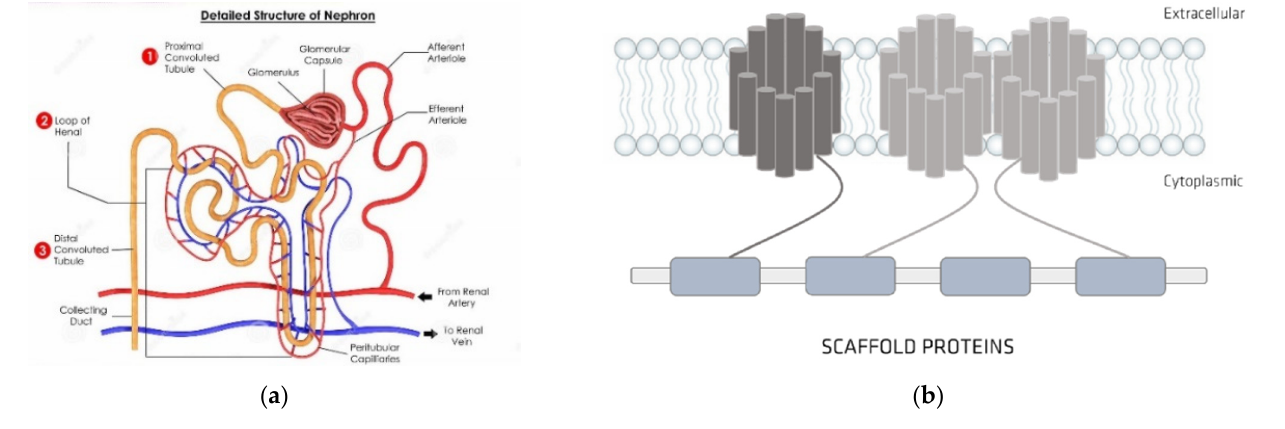
Figure 5. ( a ) nephron structure; ( b ) organic anionic transporter’s